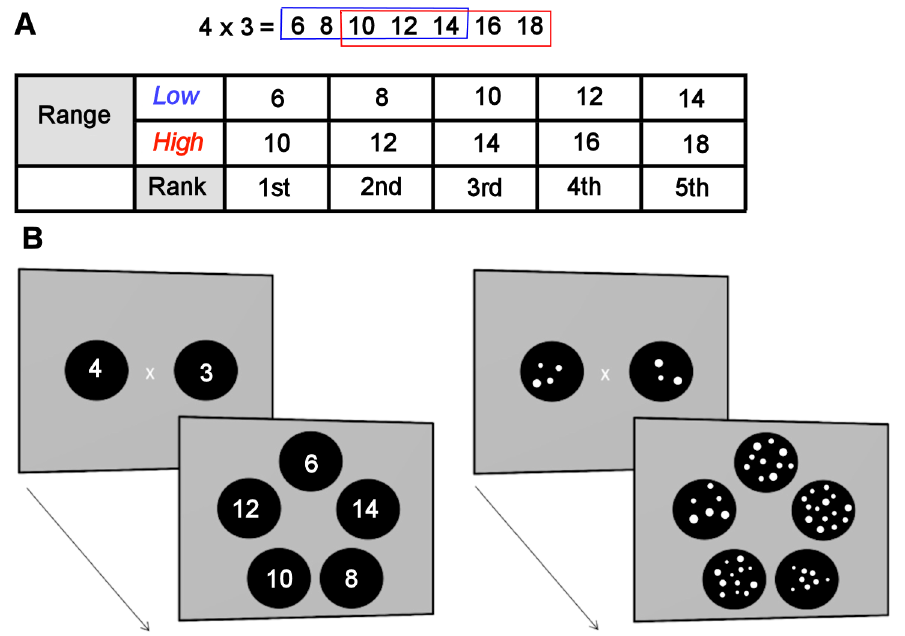
Figure 1. Task design. The correct result (C) and 6 incorrect results were created in a geometric series (symbolic: C x 1.5 i/3 & non-symbolic: C x 2 i/3 ; i from 2 3 to 3). To avoid the correct result corresponding to the ‘middle one’ among presented answer choices, only 5 of the 7 results were presented in a given trial. (A) A low range (blue) with the 4 th choice correct and a high range (red) with the 2 nd choice correct were created. (B) Illustration of the procedure using 4 6 3 low (4 th choice correct), in symbolic (left) and non-symbolic (right) format. The problem was presented horizontally for 3s, followed by the answer choices for a maximum of 4s. Responses were made with a mouse.